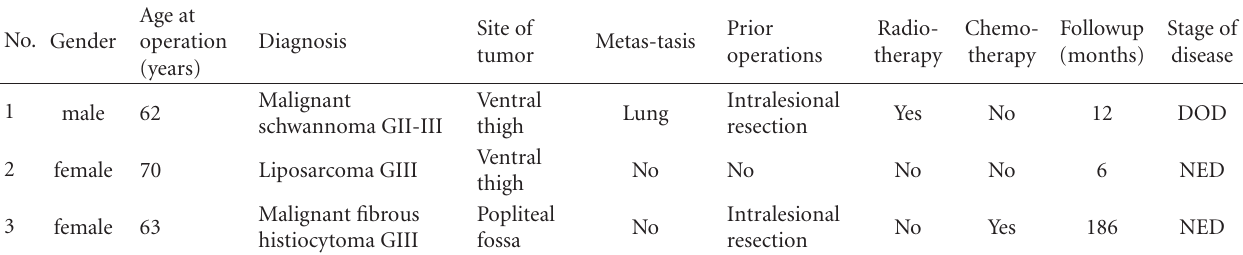
Table 1: Patient’s details.